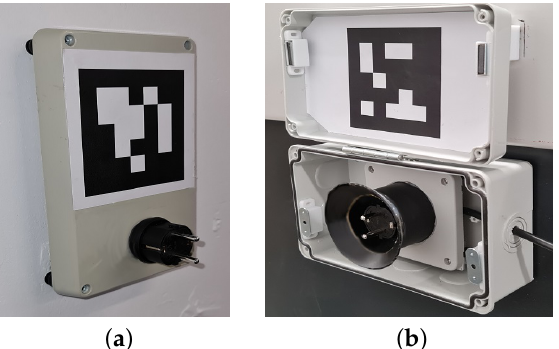
Figure 4. The plugs. ( a ) The wall-plug that hosts the power-outlet. ( b ) The vehicle